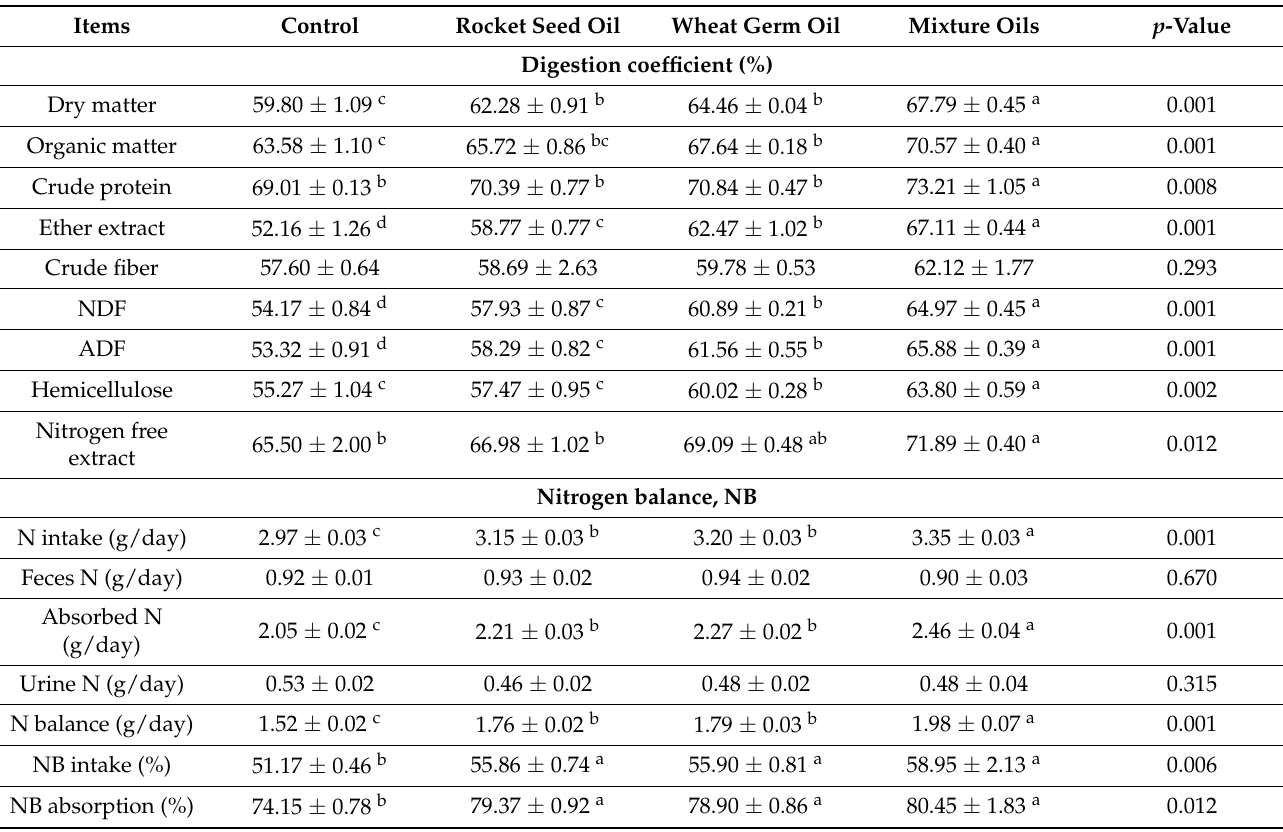
Table 3. Digestion coefficients of nutrient and nitrogen balance of experimental diets of V-line growing rabbits (5–12 weeks of age) that were administered orally with rocket seed oil, wheat germ oil, and their mixture.